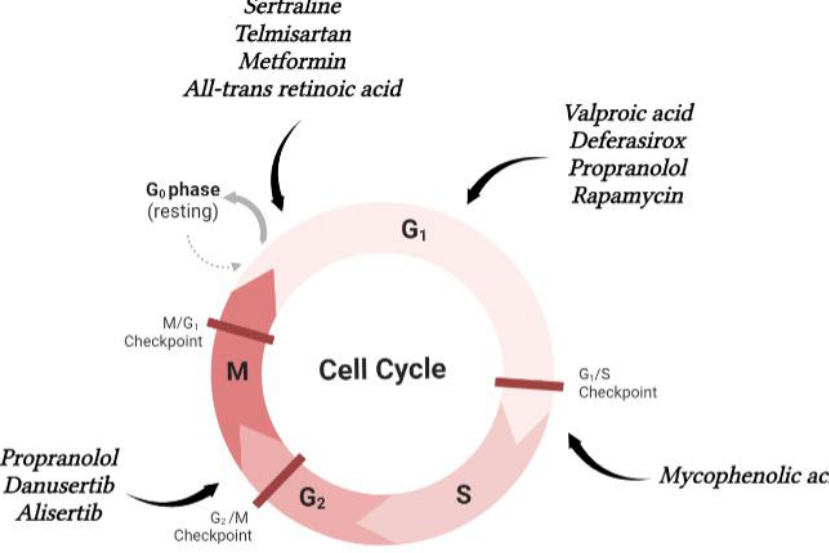
Figure 2. Schematic representation of repurposed drugs for gastric cancer that interfere in cell cycle. Additionally, in SC-M1 cells, all-trans retinoic acid increases GC cells’ resistance to lymphokine-activated killer-mediated cytotoxicity through cell cycle regulation [361]. All- trans retinoic acid displays antiproliferative characteristics and induces cell cycle arrest in AGS, MKN-45, MKN-74, NCI-N87, MKN-7 and MKN-28 GC cells by upregulating CDK inhibitors and downregulating activators of the cell cycle. Furthermore, all-trans retinoic acid targets cancer stem cells, downregulating its markers’ expression (CD44 and aldehyde dehydrogenase (ALDH) and stemness genes, including Klf4 and Sox2. In vivo, all-trans retinoic acid is able to inhibit GC progression [150]. Another investigation demonstrated that miR-542-3p coupled with sorafenib/all-trans retinoic acid in a lipid nanoparticle is effi- cient against GC. In vitro experiments showed that miR-542-3p displays an antiproliferative effect in MGC-803 GC cells and the nanocarrier encapsulation of sorafenib plus all-trans retinoic acid exhibits higher cytotoxicity when compared to individual drugs or combina- tions, suggesting that the cellular uptake of different formulations affects the therapeutic efficiency [151]. In vivo data indicate that nanoparticle encapsulation of sorafenib and miRNA displays anticancer efficiency, and miRNA coupled with sorafenib/all-trans retinoic acid in a lipid nanocarrier might be a potential therapeutic strategy in GC treatment [151]. Since long noncoding RNAs (LncRNAs) are associated with cancer development, a study found that LncHOXA10 is upregulated in GC, promoting cell proliferation, migration and invasion. On the other hand, RAR- β is downregulated and apoptosis-inhibited. In fact, LncHOXA10 can suppress RAR- β expression and all-trans retinoic acid enables RAR- β ex- pression. Thus, all-trans retinoic acid can reverse the tumourigenic function of LncHOXA10, indicating a new target and drug for GC treatment [362]. 13-cis-retinoic acid is a retinoid that derivates from vitamin A and induces changes in gene ex- pression through binding to specific nuclear receptors, resulting in apoptosis or differen- tiation of malignant or premalignant cells [153]. It is used for acne vulgaris treatment and also has been proven to be effective in the chemoprevention of aerodigestive malignancies [152,153]. It has antitumour functions in neuroblastoma [363], adult T-cell leukaemia [364] and prostate cancer [365]. A study compared all-trans retinoic acid and 13-cis-retinoic acid action on SC-M1 GC cells in vitro and in vivo. 13-cis-retinoic acid is able to inhibit GC cell growth and also tumour growth. However, the in vitro results showed that all-trans retinoic acid is more